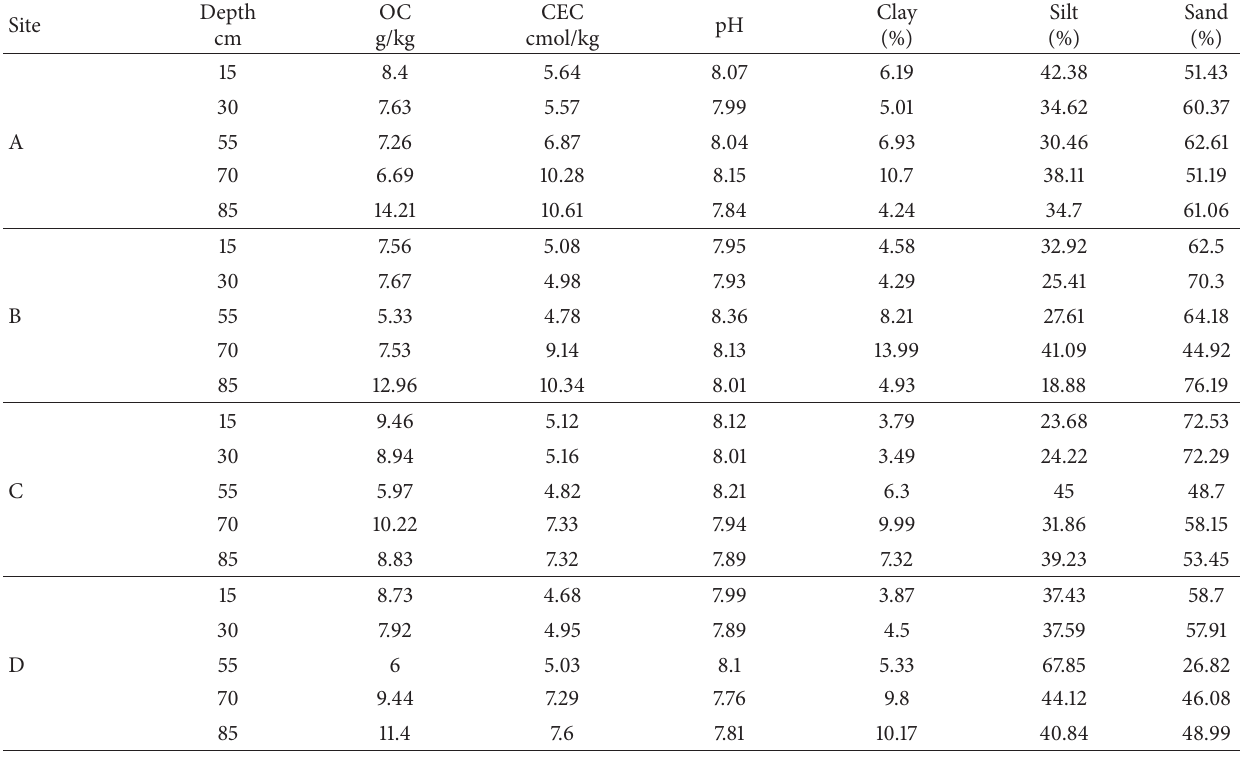
Table 2: The physical and chemical properties of the soil samples.